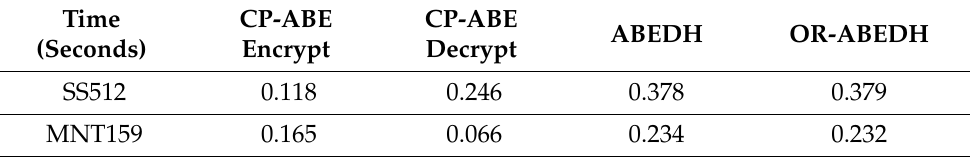
Table 3. Computation time tested for the proposed authentication protocols and the underlying CP-ABE scheme with partially hidden access